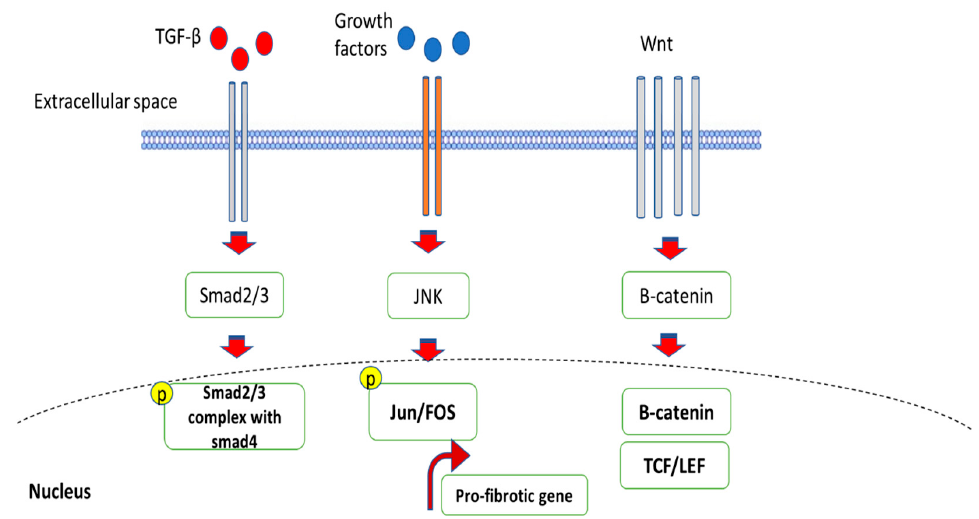
Figure 9. The schematic diagram illustrates the role of Jun N terminal kinase (JNK) in activating the pro-fibrotic genes.